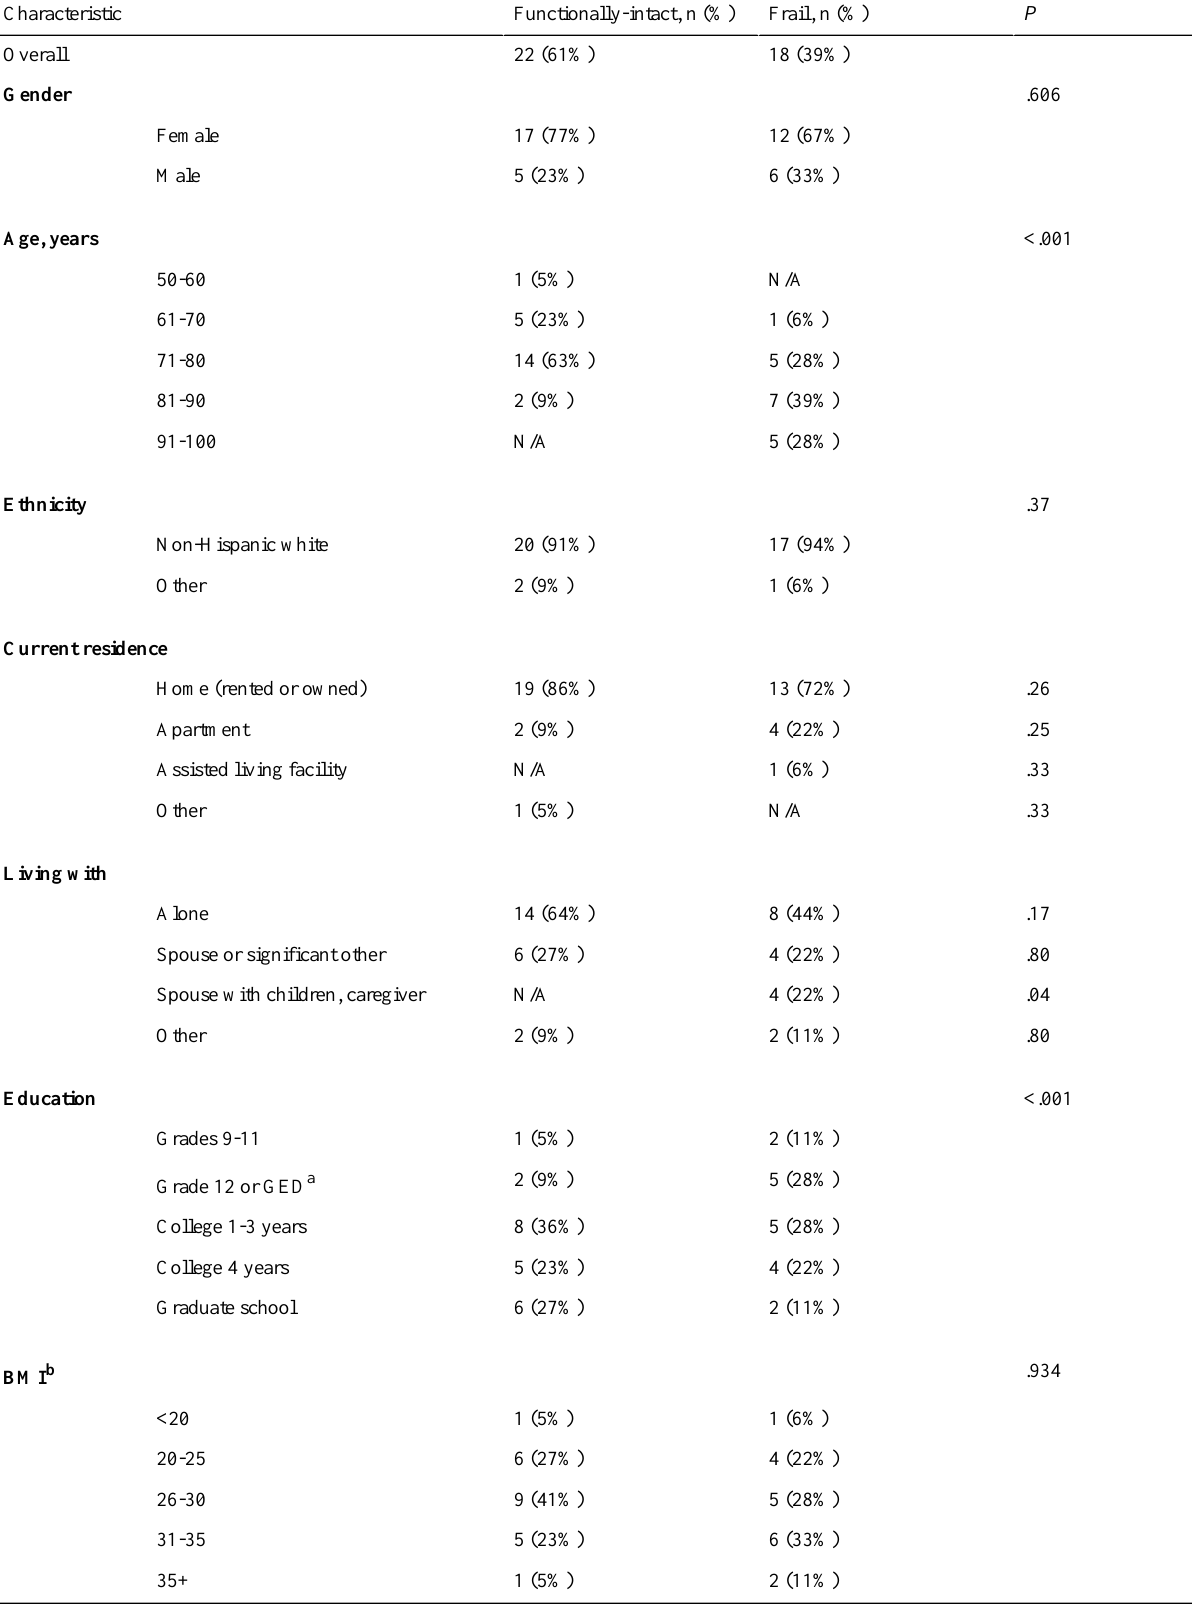
Table 1. Baseline cohort characteristics